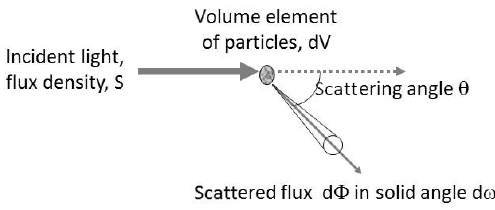
Figure 1. Definition of the volume scattering